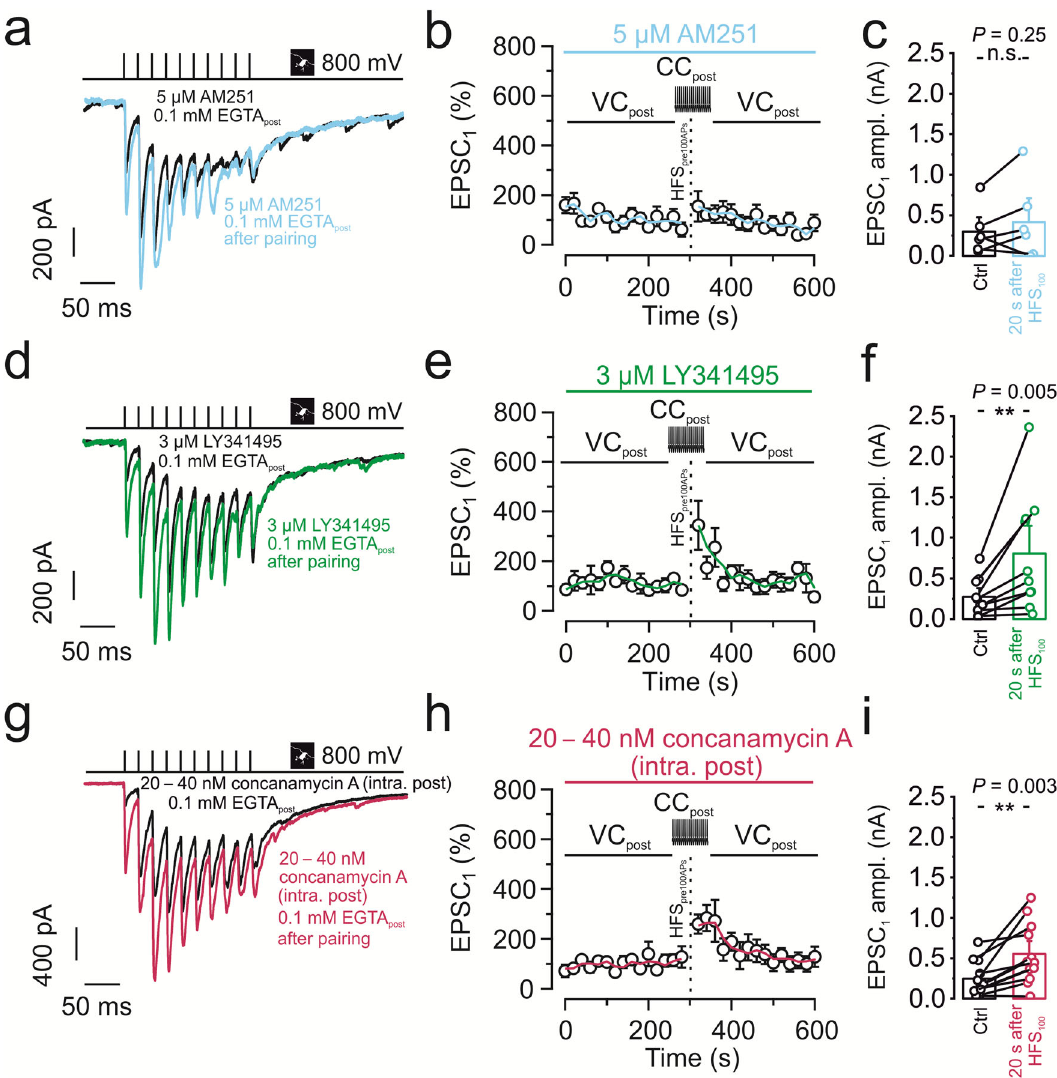
Fig. 4 Anti-associative PTP involves retrograde glutamate signaling and activation of presynaptic mGluR2/3 receptors. a – c 5 µ M of the CB1 receptor antagonist / inverse agonist AM251 did not restore PTP after pairing 100 presynaptic APs with postsynaptic APs with 0.1 mM EGTA in the postsynaptic pipette. a Representative traces of control (black) and after PTP induction (light blue). b Normalized EPSC 1 amplitude plotted versus experimental time. Black vertical dashed line indicates PTP induction, pairing HFS 100 stimulation (1 s, 100 Hz) in the presynaptic terminal (tight-seal cell-attached mode) with spiking in the postsynaptic neuron (whole-cell current-clamp con fi guration). Light blue line shows running average. Light blue horizontal bar on top indicates the application period of the CB1 receptor antagonist / inverse agonist. c Summary bar graph showing the EPSC 1 amplitude before ( “ Ctrl ” ; black) and after pairing 100 presynaptic APs with postsynaptic APs ( “ 20 s after HFS 100 ” ; light blue) in the presence of 5 µ M AM251. d – f 3 µ M of the mGluR2 / mGluR3 antagonist LY341495 largely restored PTP after pairing 100 presynaptic APs with postsynaptic APs with 0.1 mM EGTA in the postsynaptic pipette. d Representative traces of control (black) and after PTP induction (green). e Normalized EPSC 1 amplitude plotted versus experimental time. Black vertical dashed line indicates PTP induction, pairing HFS 100 stimulation (1 s, 100 Hz) in the presynaptic terminal (tight-seal cell-attached mode) with spiking in the postsynaptic neuron (whole-cell current-clamp con fi guration). Green line shows running average. Green horizontal bar on top indicates the application period of the mGluR2/3 receptor antagonist. f Summary bar graph showing the EPSC 1 amplitude before ( “ Ctrl ” ; black) and after pairing 100 presynaptic APs with postsynaptic APs ( “ 20 s after HFS 100 ” ; green) in the presence of 3 µ M LY341495. g – i 20 – 40 nM of the H + -ATPase inhibitor concanamycin A (also called folimycin) in the postsynaptic pipette largely restored PTP after pairing 100 presynaptic APs with postsynaptic APs. g Representative traces of control (black) and after PTP induction (magenta). h Normalized EPSC 1 amplitude plotted versus experimental time. Black vertical dashed line indicates PTP induction, pairing HFS 100 stimulation (1 s, 100 Hz) in the presynaptic terminal (tight-seal cell-attached mode) with spiking in the postsynaptic neuron (whole-cell current-clamp con fi guration). Magenta line shows running average. Magenta horizontal bar on top indicates the application period of the H + -ATPase inhibitor. Note that the time course of PTP in the presence of concanamycin A is slightly different from that of control data sets, suggesting that a remaining suppression is more short-lasting. i Summary bar graph showing the EPSC 1 amplitude before ( “ Ctrl ” ; black) and after pairing 100 presynaptic APs with postsynaptic APs ( “ 20 s after HFS 100 ” ; magenta) in the presence of 20 – 40 nM of concanamycin A. c , f , i Boxes represent mean values, and circles show individual measurements. A paired non-parametric two-sided Wilcoxon signed rank test was used to test for statistical signi fi cance. ** indicates P < 0.01, and n.s. denotes non-signi fi cant difference ( P ≥ 0.05). Data in ( b , c ), ( e , f ), and ( h , i ) are from 6, 10, and 12 pairs, respectively. Error bars indicate